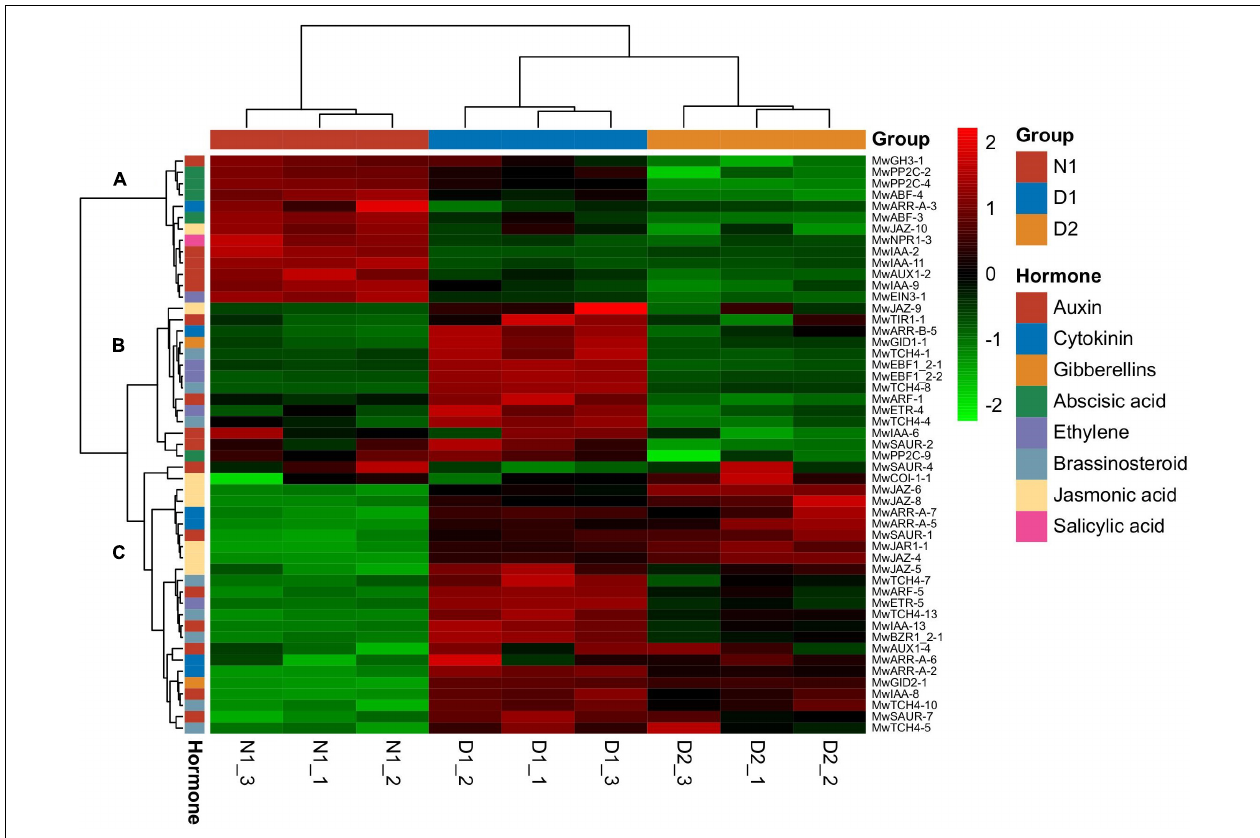
FIGURE 4 | Heatmap of differentially expressed genes (DEGs) involved in plant hormone signal transduction (map04075) during different dormancy phases at 2019–2020 in Magnolia wufengensis